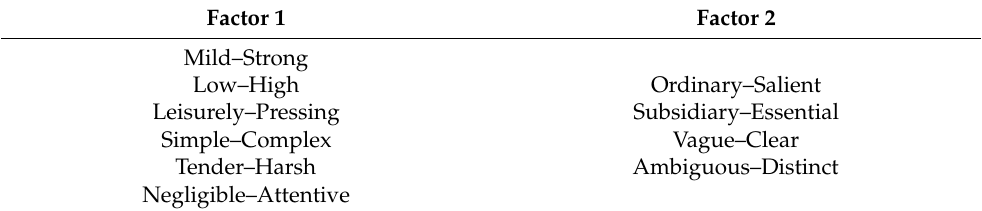
Table 3. KWs strongly associated with reduced